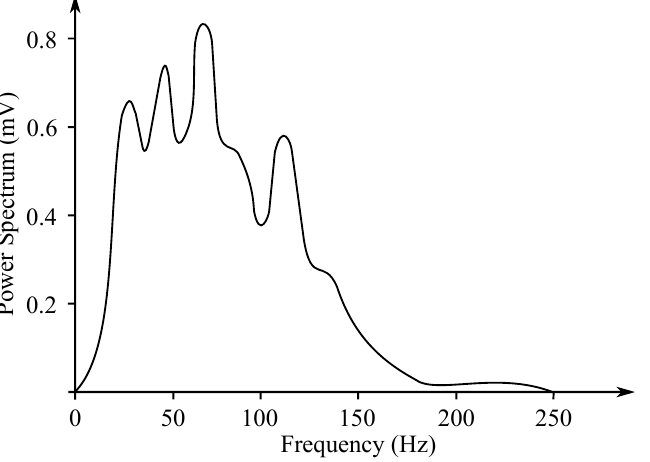
Figure 3. Example of the surface EMG frequency spectrum (based on the work in [18]). When measuring the EMG, the so-called maximum free contraction of the muscle is evaluated. The required strength of contraction is achieved with the gradual activation of motor units. The number of activated units required for this contraction varies